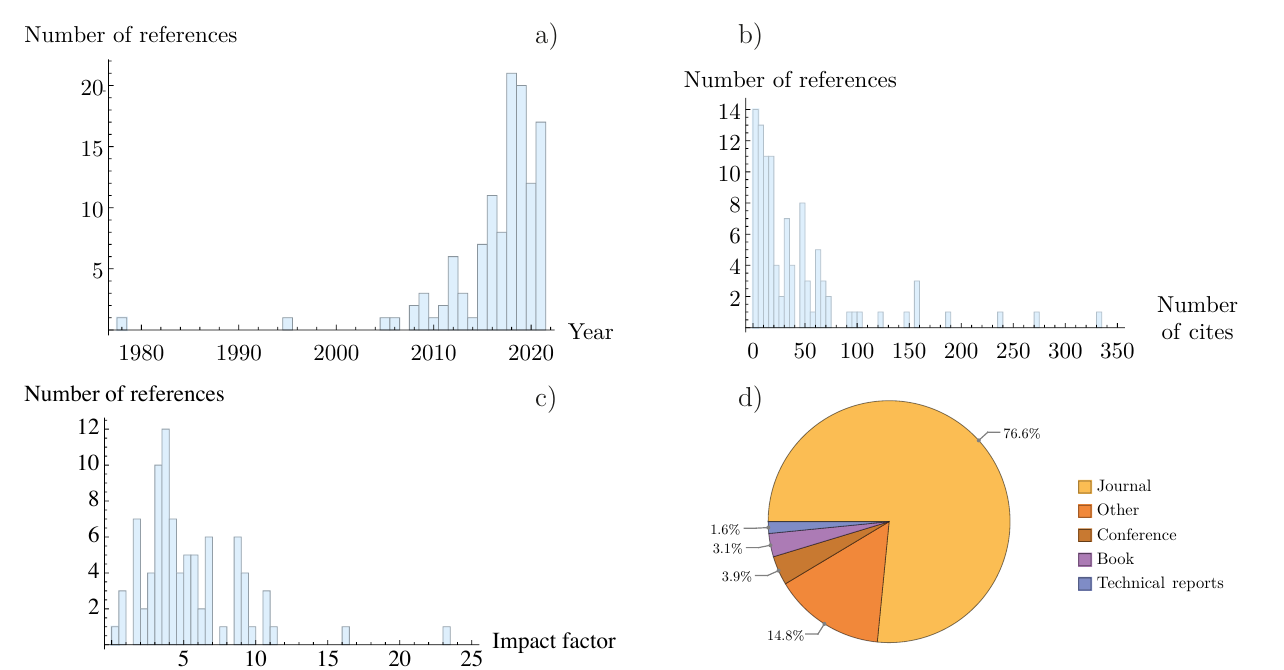
Figure 1. Statistics of the revised literature. A histogram shows the results of several reviewed references: ( a ) number of citations, ( b ) year of publication, and ( c ) impact factor. ( d ) Percentage of literature revised divided into journal papers, conferences, books, technical reports, and